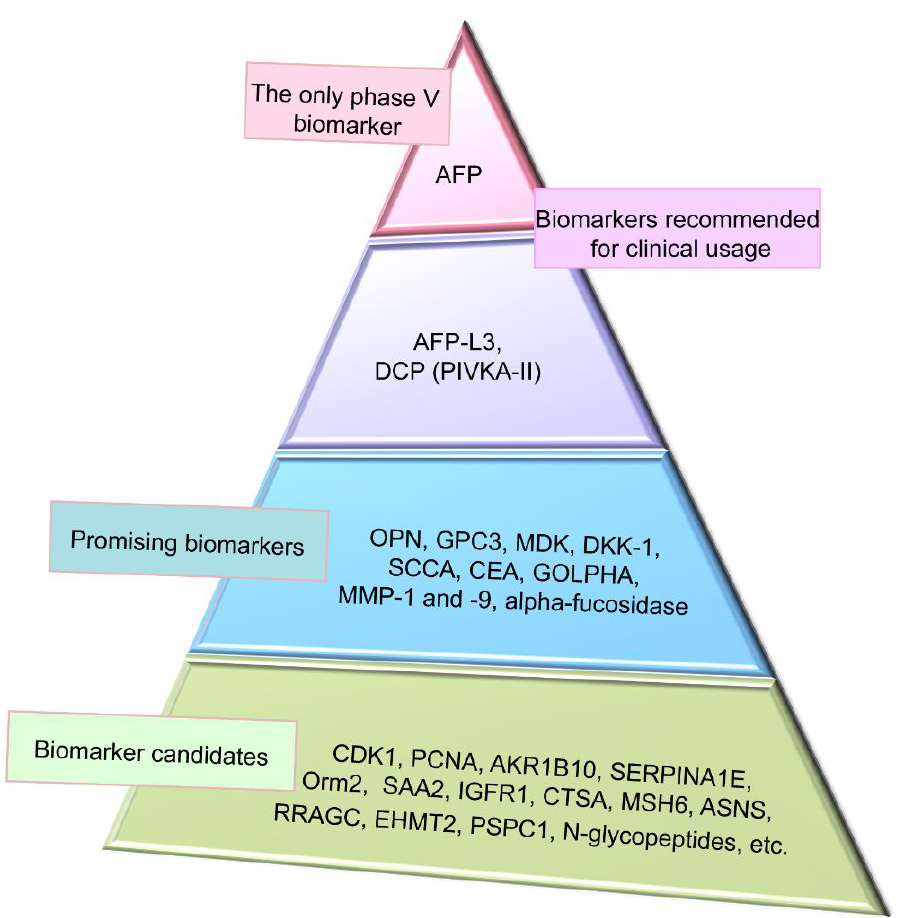
Figure 5. Representation of clinical application of hepatocellular carcinoma (HCC) proteomic biomarkers. Alpha-fetoprotein (AFP) is on the top as the only biomarker, which has passed phase V of clinical trials to be recommended for clinical usage. AFP has low sensitivity from 39 to 64% and specificity from 76 to 91%. Combination of AFP with other biomarkers and imaging techniques significantly improves performance of HCC detection. Gender, age, AFP, AFP-L3, and des-gamma- carboxyprothrombin (GALAD) score is also recommended for clinical usage and has 87% sensitivity and 60% specificity. Promising biomarkers have positions between recommended and candidate biomarkers. Novel HCC biomarker candidates identified by proteomic profiling technologies are needed further verification and validation and are located on the base of the triangle.